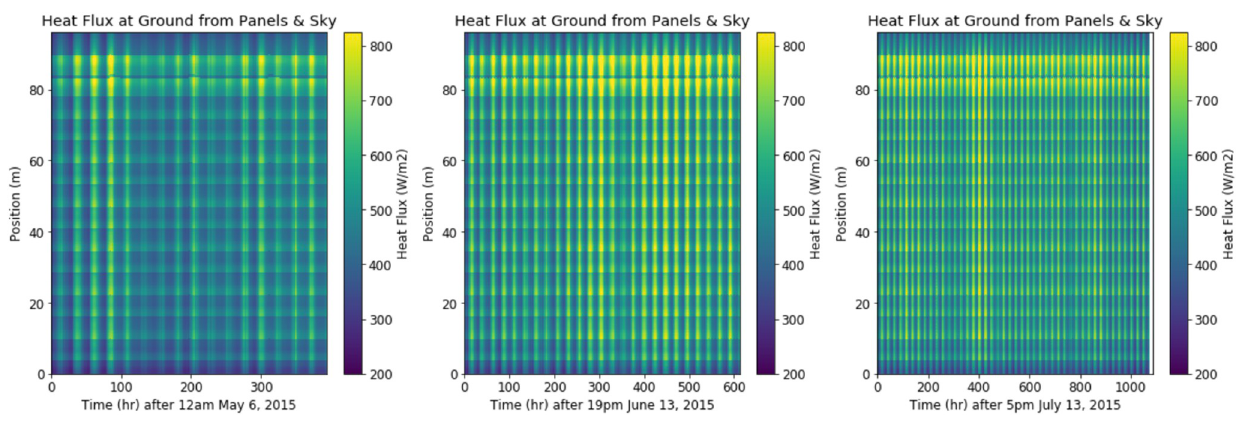
Fig 12. Plots of heat flux over space and